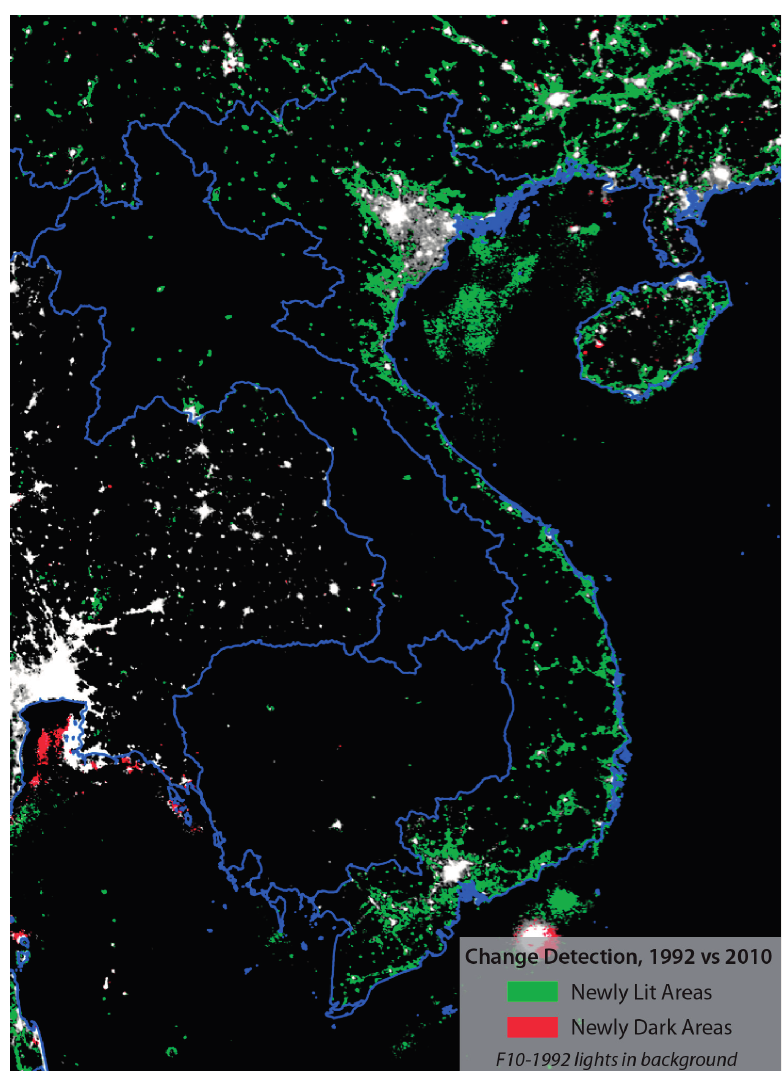
Figure 1. Change in nighttime lights in Vietnam, 1992 vs. 2010. Source: Image and data processing by the National Oceanic and Atmospheric Administration (NOAA)’s National Geophysical Data Center. Defense Meteorological Satellite Program (DMSP) data collected by the US Air Force Weather